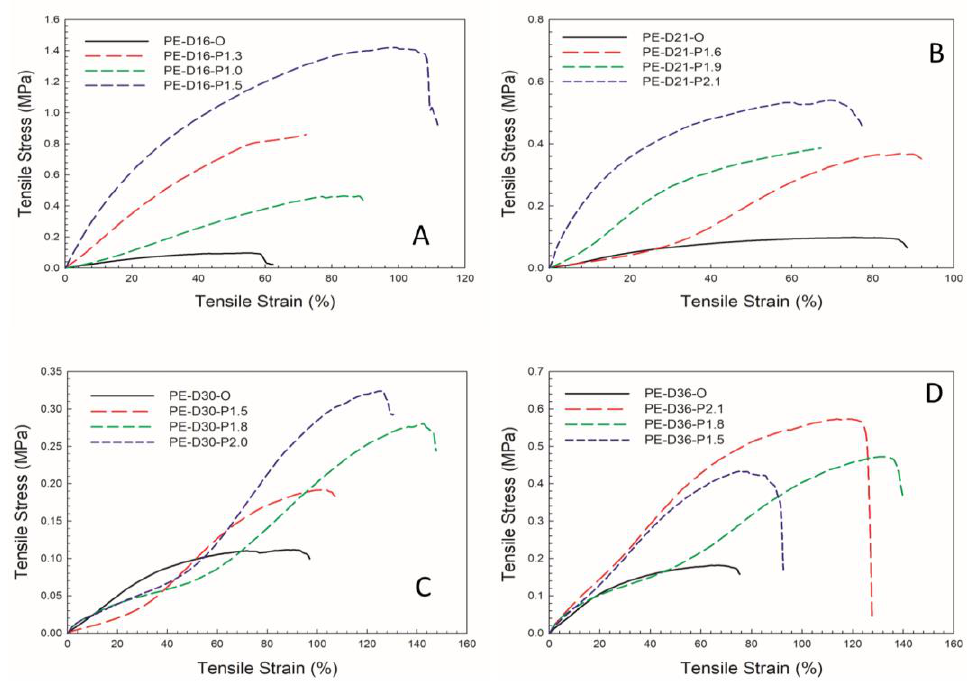
Figure 7. Tensile stress – strain plots of the auxetic and original foams based on ( A ) D16, ( B ) D21, ( C ) D30 and ( D ) D36. ( C ) D30 and ( D )